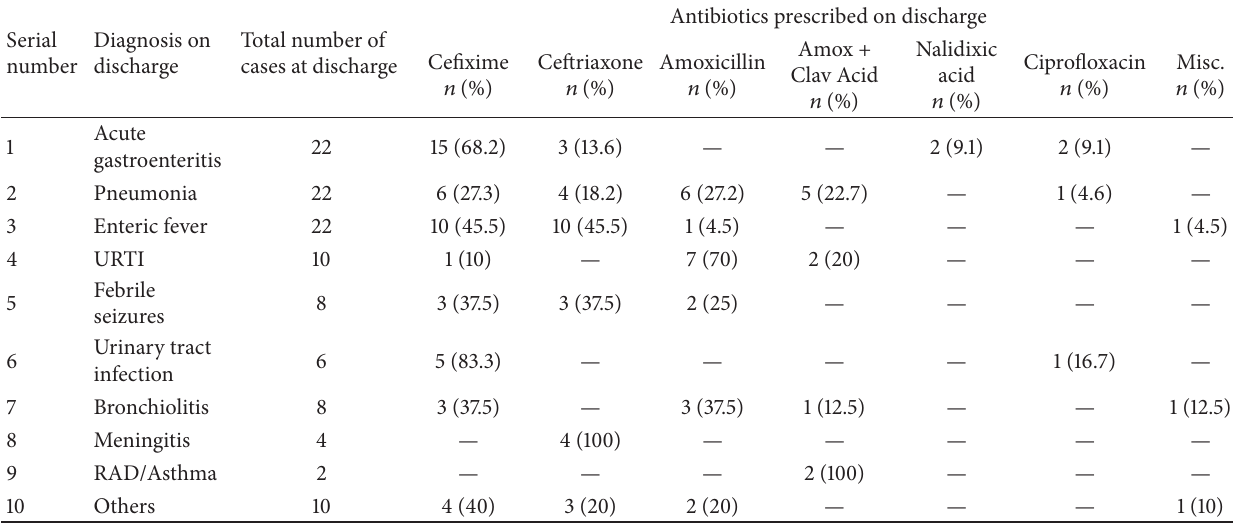
Table 2: Diagnosis and antibiotics prescribed at the time of